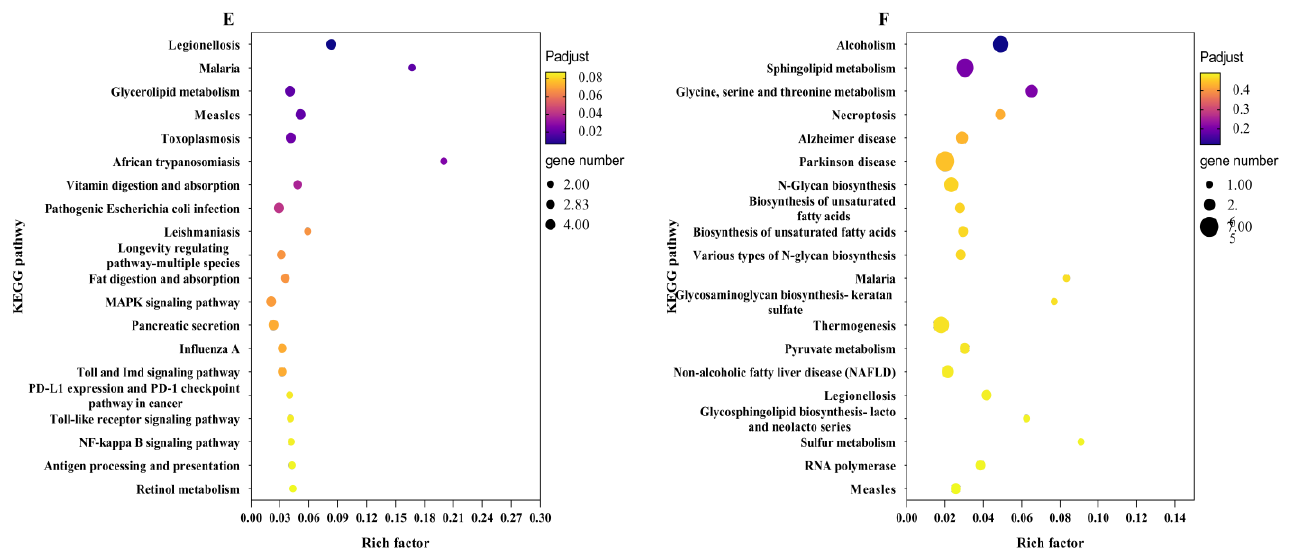
Figure 4. Enrichment map of DEGs in KEGG pathways. RRSV-free BPH were treated with Tween-80 (CK) or Metarhizium anisopliae YTTR (SF) and RRSV-carrying BPH were also treated with Tween-80 (SV) or M. anisopliae YTTR (CI), respectively. After 12 h treatment, RNA-seq was performed. The expression of DEGs among the four treatment groups (CK, SF, SV, and CI) were compared with any two comparision groups. CI vs CK, SF vs CK, SV vs CK, CI vs SF, CI vs SV, and SF vs SV were defined. A − F respectively means the result of the enrichment map in the comparison group of CI vs CK, SF vs CK, SV vs CK, CI vs SF, CI vs SV, and SF vs SV.